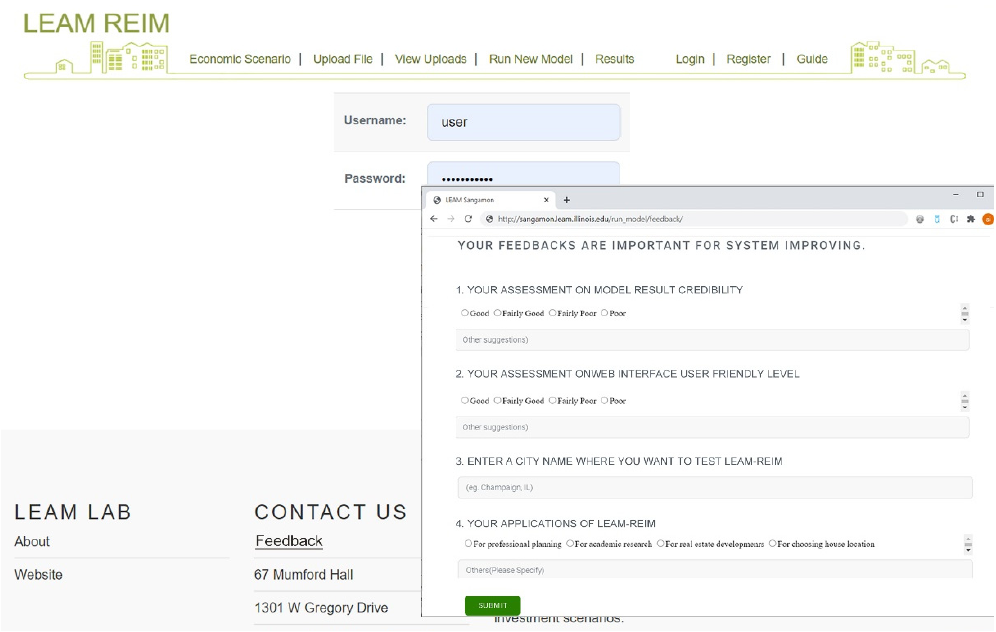
Figure 5. LEAM PSS user feedback and log in.